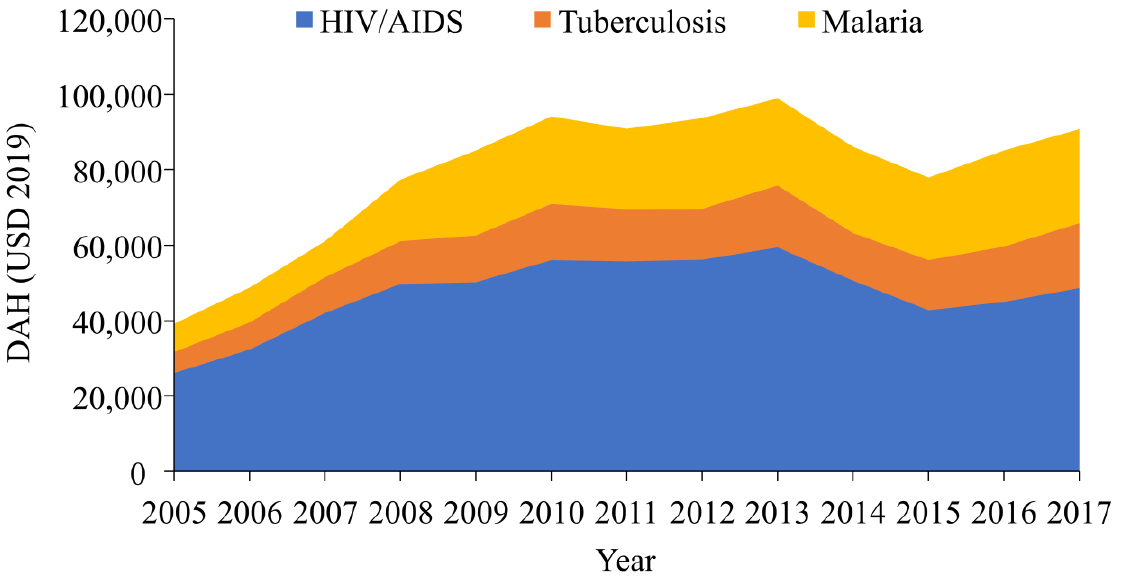
Annual trend of Global Burden of Disease Health Financing are in constant (million of 2019 USD), DAH per capita (2019 USD), DAH = development assistance for heath.